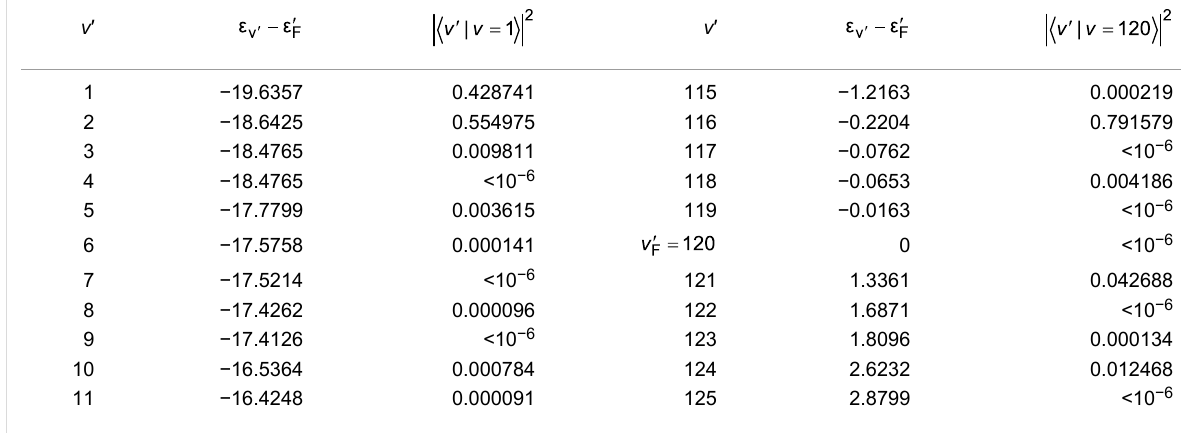
Table 1: Squared overlap integrals between the lowest and highest occupied valence states in the neutral C 60 molecule ( v = 1, ε 1 = − 18.8575 eV and v = v F = 120, ε 120 = ε F = 0, respectively) and some valence states in the ionized C 60 molecule (where = − 3.132 eV). The reported values confirm the remarkable non adiabatic effects induced by core hole creation (see also below in Figure 2).